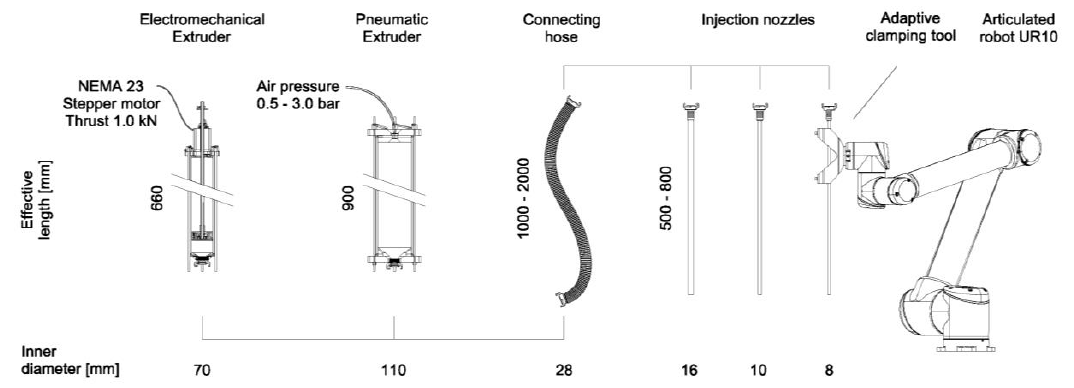
Figure 4. Robotic setup: electromechanical and pneumatic extruder, hose, nozzles with different diameters, and robot with nozzle.